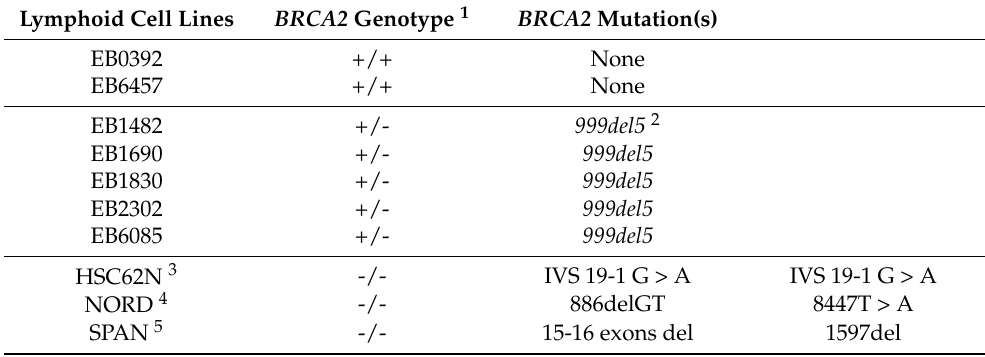
Table 1. List of lymphoid cell lines used in the study including information of the BRCA2 genotype and mutation(s). Lymphoid Cell